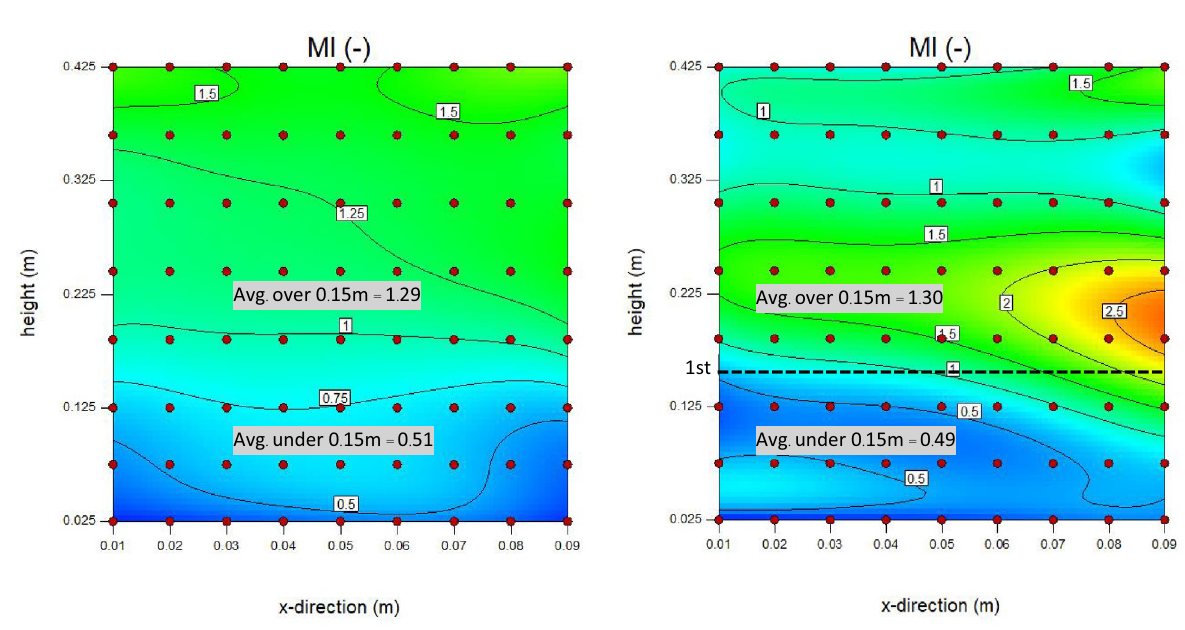
Figure 14. Contours of time-averaged local mixing index (MI) in case of U g = 0.7